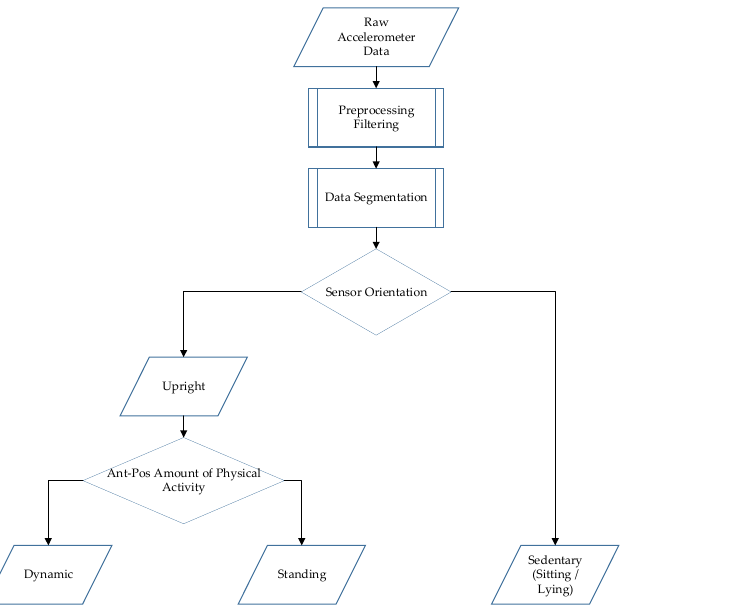
Figure A1. Schematic overview of the data processing of the physical activity classification algorithm (HFITAL) worn on the upper leg.